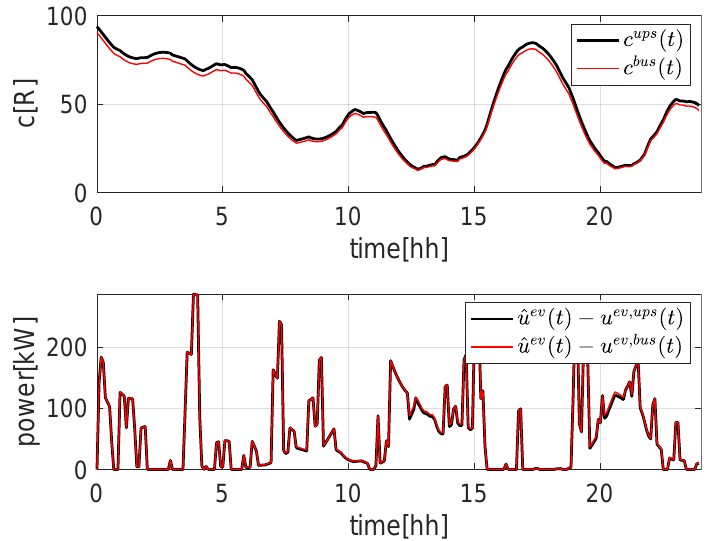
Figure 12. Comparison between power delivered to PEVs (bottom) and variable cost c ( t ) (top) for BUS and UPS configurations.